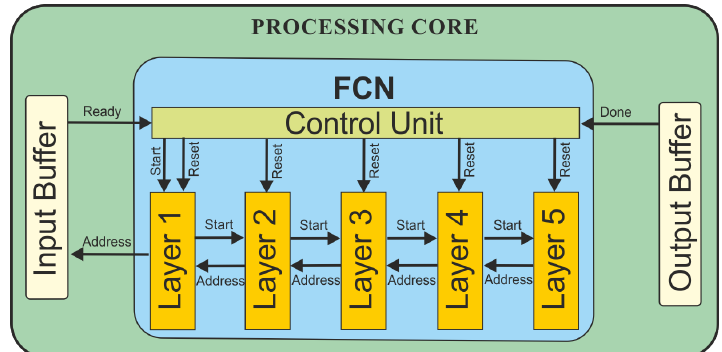
Figure 1. Scheme of the HPR